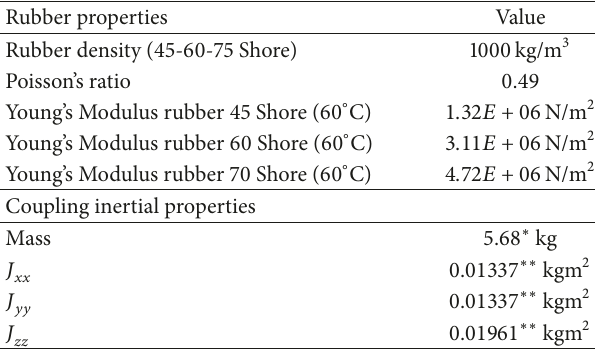
Table 4: Input data for FE analysis.